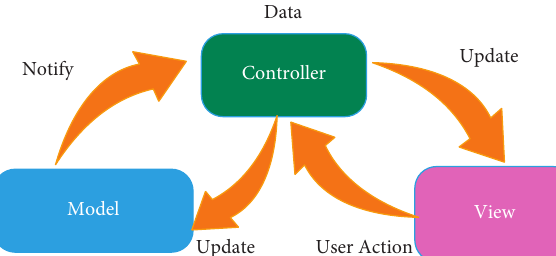
Figure 3: Architecture of the inner layer of the DIR.